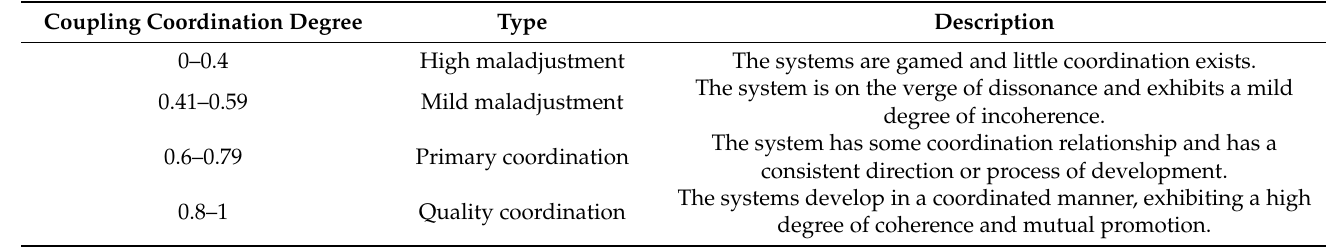
Table 3. Classification of coupling coordination